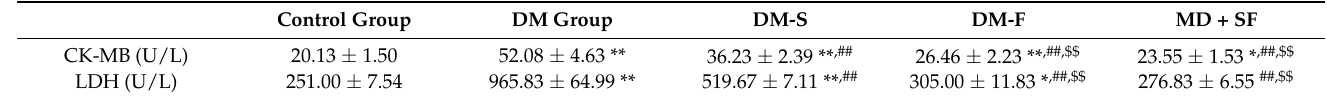
Table 2. Effect of exercise and dapagliflozin on cardiac enzymes data presented as mean ± stand ard